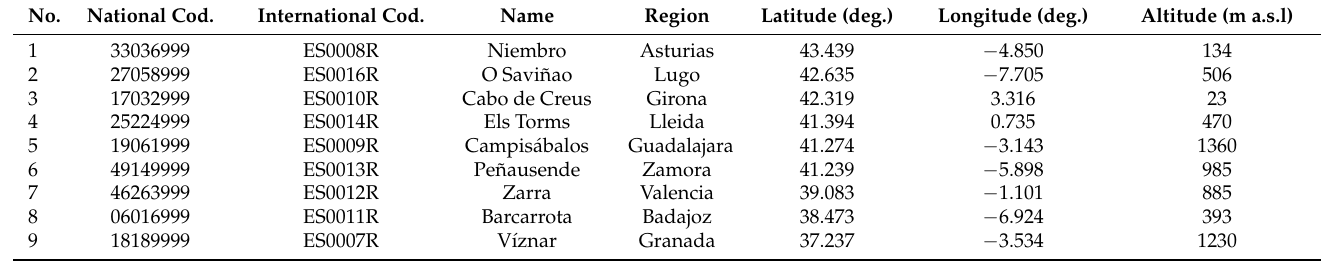
Table 1. Features of the background stations belonging to the network EMEP/VAG/CAMP and used in the study.